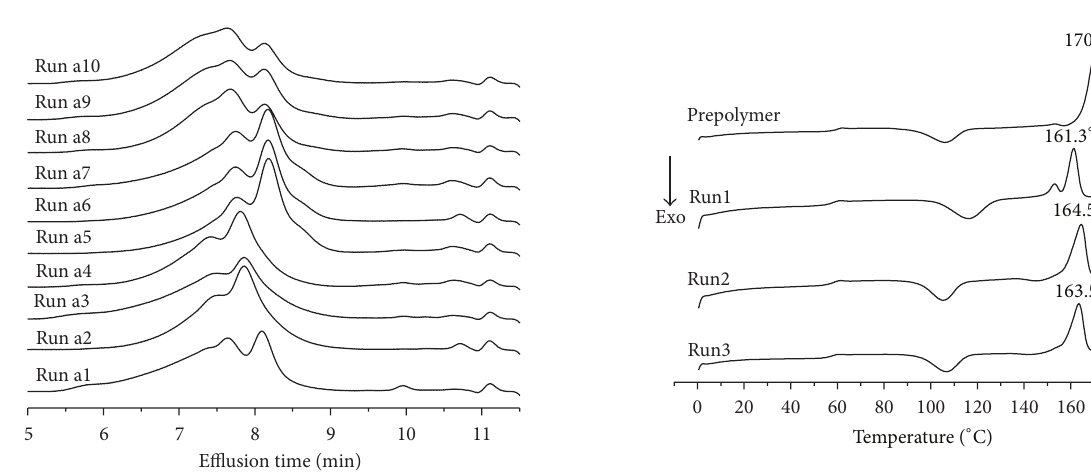
Figure 5: DSC thermogram of the prepolymer and the PLA chain extended with different adding amount